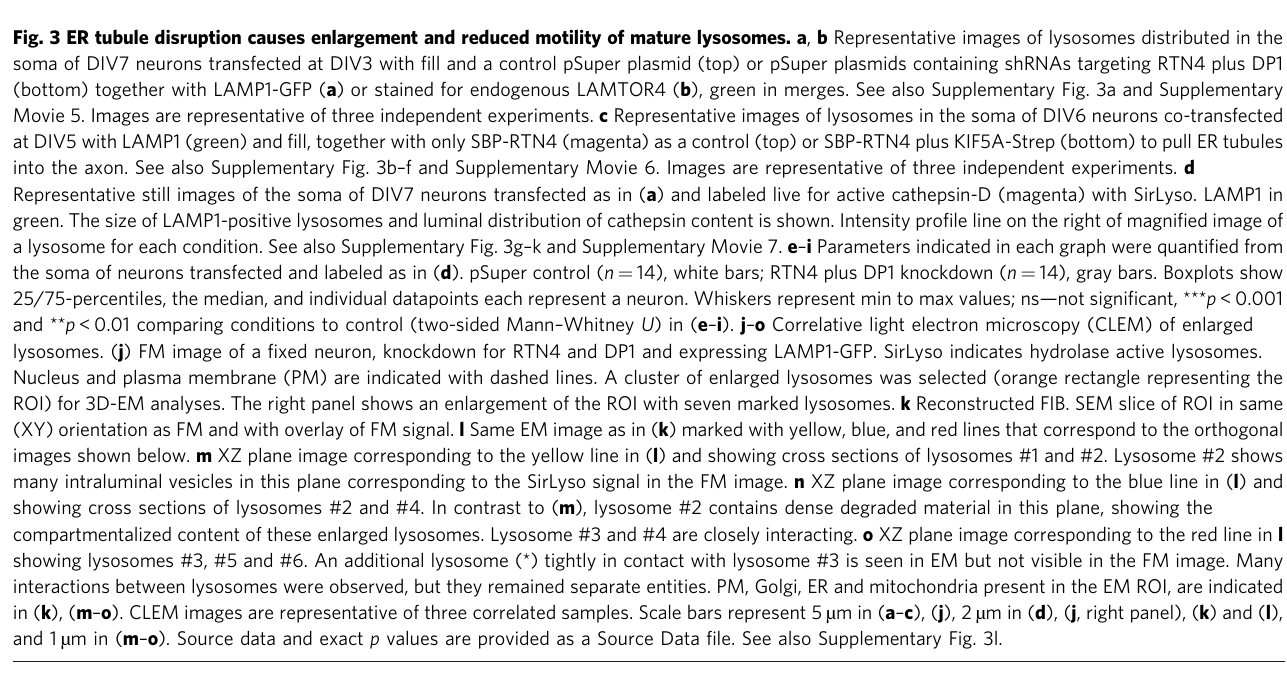
Fig. 3 ER tubule disruption causes enlargement and reduced motility of mature lysosomes. a , b Representative images of lysosomes distributed in the soma of DIV7 neurons transfected at DIV3 with fi ll and a control pSuper plasmid (top) or pSuper plasmids containing shRNAs targeting RTN4 plus DP1 (bottom) together with LAMP1-GFP ( a ) or stained for endogenous LAMTOR4 ( b ), green in merges. See also Supplementary Fig. 3a and Supplementary Movie 5. Images are representative of three independent experiments. c Representative images of lysosomes in the soma of DIV6 neurons co-transfected at DIV5 with LAMP1 (green) and fi ll, together with only SBP-RTN4 (magenta) as a control (top) or SBP-RTN4 plus KIF5A-Strep (bottom) to pull ER tubules into the axon. See also Supplementary Fig. 3b – f and Supplementary Movie 6. Images are representative of three independent experiments. d Representative still images of the soma of DIV7 neurons transfected as in ( a ) and labeled live for active cathepsin-D (magenta) with SirLyso. LAMP1 in green. The size of LAMP1-positive lysosomes and luminal distribution of cathepsin content is shown. Intensity pro fi le line on the right of magni fi ed image of a lysosome for each condition. See also Supplementary Fig. 3g – k and Supplementary Movie 7. e – i Parameters indicated in each graph were quanti fi ed from the soma of neurons transfected and labeled as in ( d ). pSuper control ( n = 14), white bars; RTN4 plus DP1 knockdown ( n = 14), gray bars. Boxplots show 25/75-percentiles, the median, and individual datapoints each represent a neuron. Whiskers represent min to max values; ns — not signi fi cant, *** p < 0.001 and ** p < 0.01 comparing conditions to control (two-sided Mann – Whitney U ) in ( e – i ). j – o Correlative light electron microscopy (CLEM) of enlarged lysosomes. ( j ) FM image of a fi xed neuron, knockdown for RTN4 and DP1 and expressing LAMP1-GFP. SirLyso indicates hydrolase active lysosomes. Nucleus and plasma membrane (PM) are indicated with dashed lines. A cluster of enlarged lysosomes was selected (orange rectangle representing the ROI) for 3D-EM analyses. The right panel shows an enlargement of the ROI with seven marked lysosomes. k Reconstructed FIB. SEM slice of ROI in same (XY) orientation as FM and with overlay of FM signal. l Same EM image as in ( k ) marked with yellow, blue, and red lines that correspond to the orthogonal images shown below. m XZ plane image corresponding to the yellow line in ( l ) and showing cross sections of lysosomes #1 and #2. Lysosome #2 shows many intraluminal vesicles in this plane corresponding to the SirLyso signal in the FM image. n XZ plane image corresponding to the blue line in ( l ) and showing cross sections of lysosomes #2 and #4. In contrast to ( m ), lysosome #2 contains dense degraded material in this plane, showing the compartmentalized content of these enlarged lysosomes. Lysosome #3 and #4 are closely interacting. o XZ plane image corresponding to the red line in l showing lysosomes #3, #5 and #6. An additional lysosome (*) tightly in contact with lysosome #3 is seen in EM but not visible in the FM image. Many interactions between lysosomes were observed, but they remained separate entities. PM, Golgi, ER and mitochondria present in the EM ROI, are indicated in ( k ), ( m – o ). CLEM images are representative of three correlated samples. Scale bars represent 5 µ m in ( a – c ), ( j ), 2 µ m in ( d ), ( j , right panel), ( k ) and ( l ), and 1 µ m in ( m – o ). Source data and exact p values are provided as a Source Data fi le. See also Supplementary Fig.